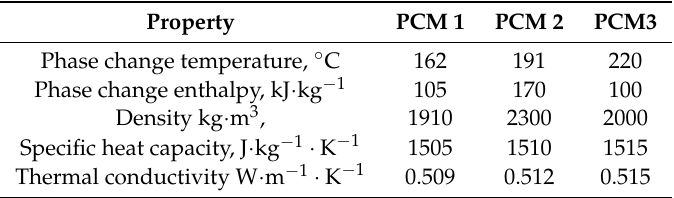
Table 3. Phase change material (PCM) properties